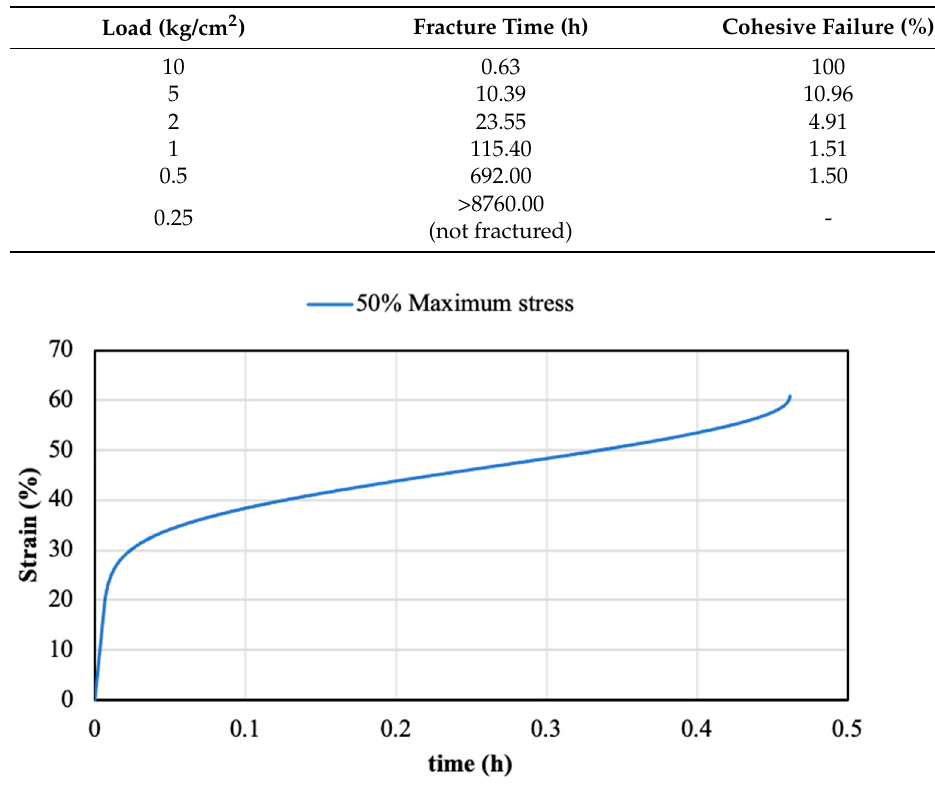
Table 7. Average failure time and mode for different load values.